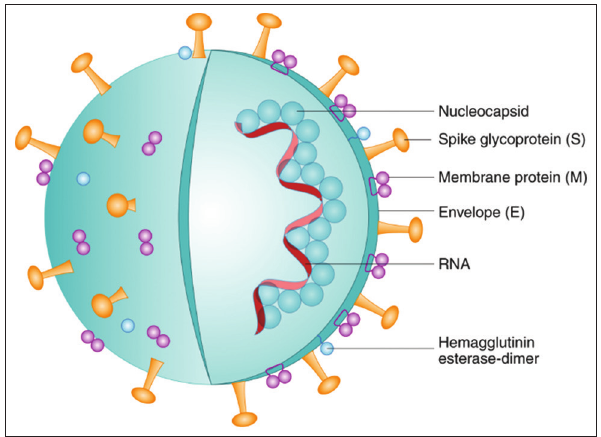
Figure-5: The structure of SARS-CoV-2 with different cell surface membrane proteins and the attachment of spike protein of SARS-CoV-2 with the receptor angiotensin- converting enzyme.